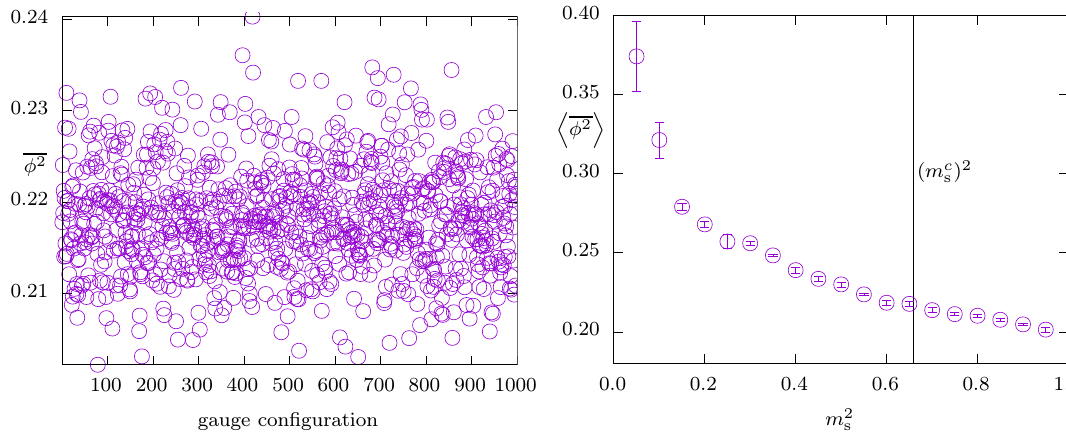
Figure 2. Spatial average of squared scalar (cid:12)eld as function of Monte-Carlo time for (cid:12) = 14, (cid:20) = 0 : 27233, m 2 = 0 : 6594826 (left) and its expectation as function of m 2 s